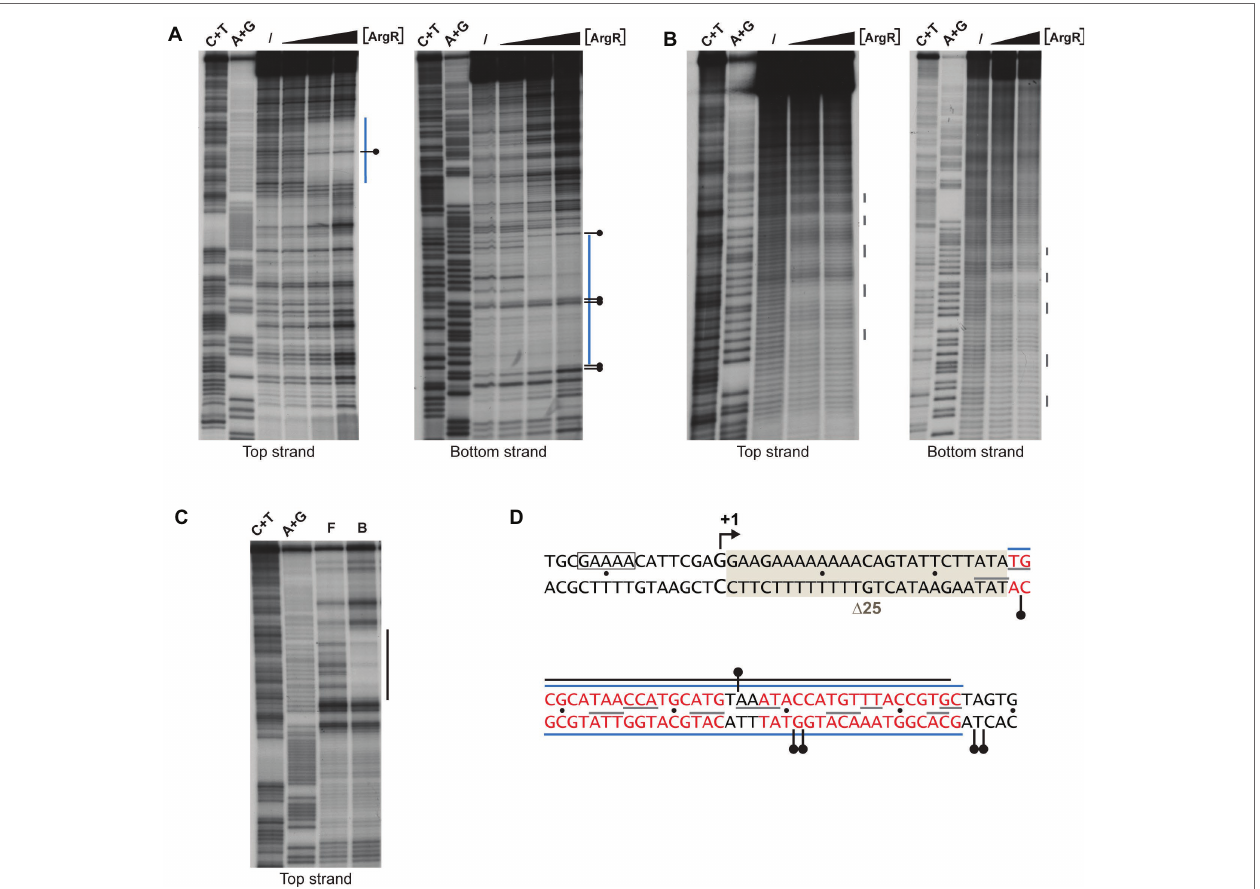
FIGURE 6 | Enzymatic and chemical footprinting of ArgR binding to the lrp control region. (A) DNase I footprinting. A blue bar represents the zone of protection. A short horizontal bar with a dot represents a site that becomes hyperreactive to DNase I cleavage upon ArgR binding. ArgR concentrations used are 0, 0.39, 3.91, and 39.1 nM. C + T and A + G correspond to the Maxam-Gilbert sequencing reactions. (B) Hydroxyl radical footprinting. ArgR concentrations used are 0, 39.1 and 78.3 nM. Short gray colored vertical lines represent sites of protection. (C) In gel footprinting with the [(OP) 2 -Cu + ] ion. F and B correspond to free and ArgR-bound DNA recovered from gel after treatment with the [(OP) 2 -Cu + ] ion. (D) Nucleotide sequence with indication of zones of protection. Symbols are as in panels A, B and C. Red colored letters represent the 18 bp ARG boxes. The −10 promoter element is boxed. The 25-bp deletion of mutant ∆25 used for reporter gene assays ( Figure 8 ) is gray shaded. The Lrp binding site as defined by DNase I footprinting (Wang et al., 1994) extends from position −106 to −20 and is not included in this